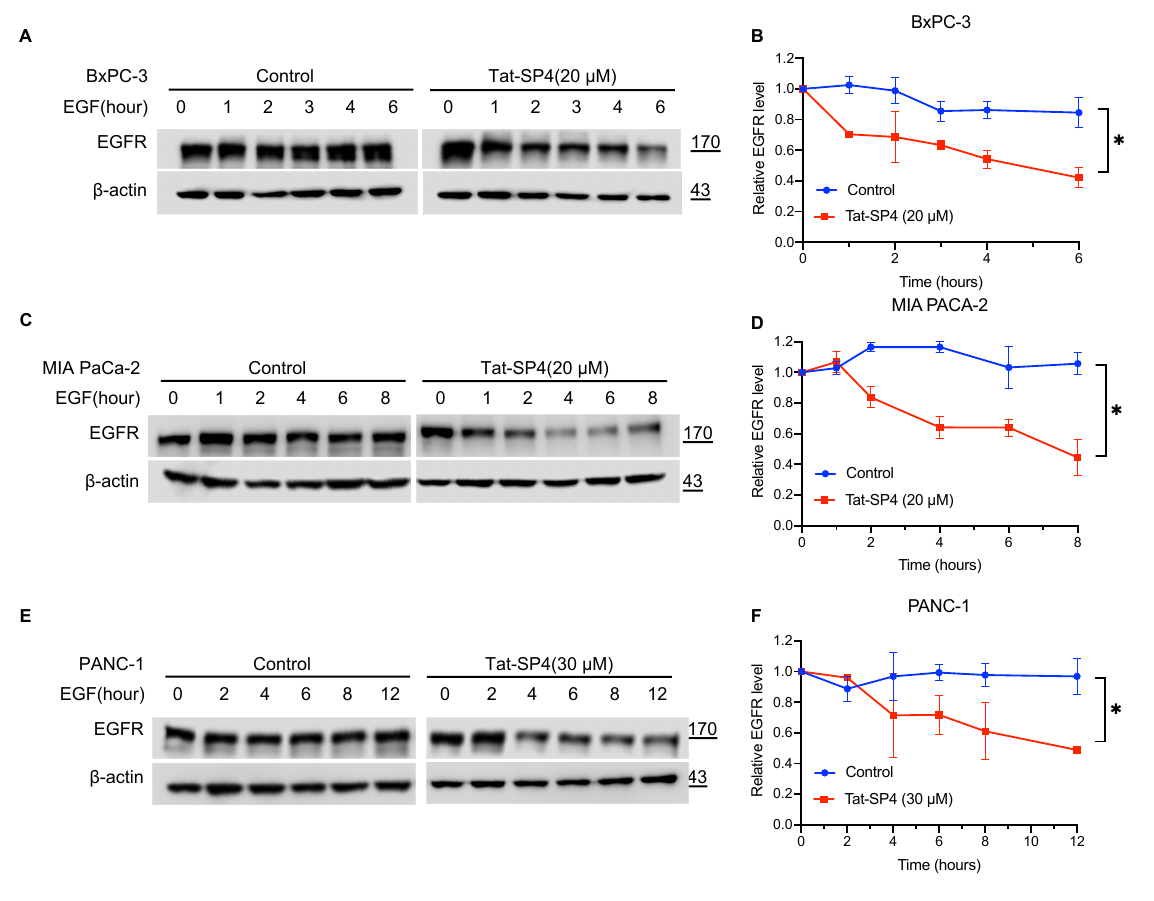
Figure 2. Tat-SP4 promoted endolysosomal degradation in PDAC cells. ( A ) Western blot to assess the EGFR levels in BxPC-3 cells. Cells were starved overnight and were treated with 200 ng/mL EGF together with vehicle control or 20 µ M Tat-SP4 for the indicated times. ( B ) Time-dependent plots to quantify the EGFR degradation profile in BxPC-3 cells ( A ). ( C , E ) Similar Western blots as ( A ), but cells are MIA PaCa-2 and PANC-1, respectively. ( D , F ) Time-dependent plots to quantify the EGFR degradation profile in MIA PaCa-2 ( C ) and PANC-1 ( E ), respectively. Data are presented as mean ± SEM from three independent experiments; * p < 0.05. For Original Western Blots, see File